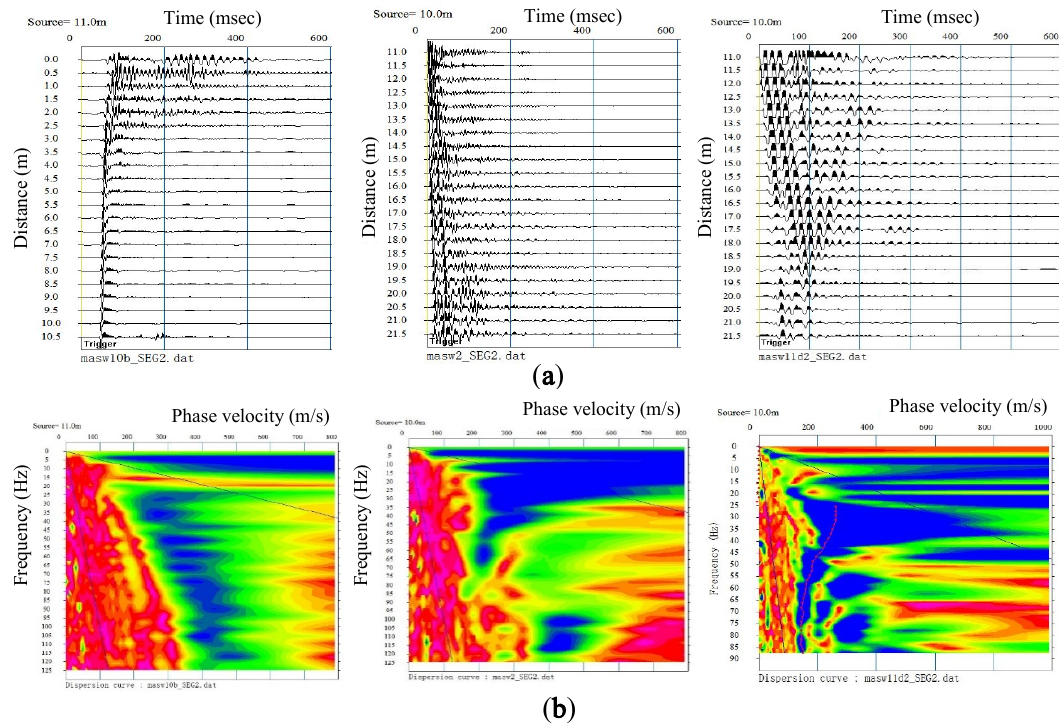
Figure 1. Data recorded at Krakal–Sadranan α -section: ( a ) Filtered shot gather records; ( b ) f-v diagram for each data in (a).